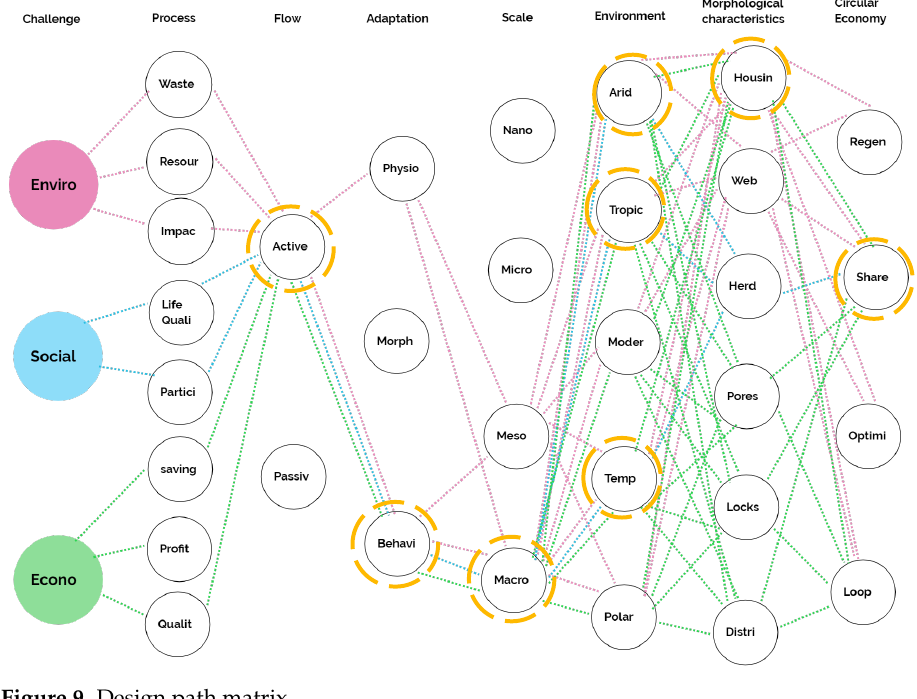
Figure 9. Design path